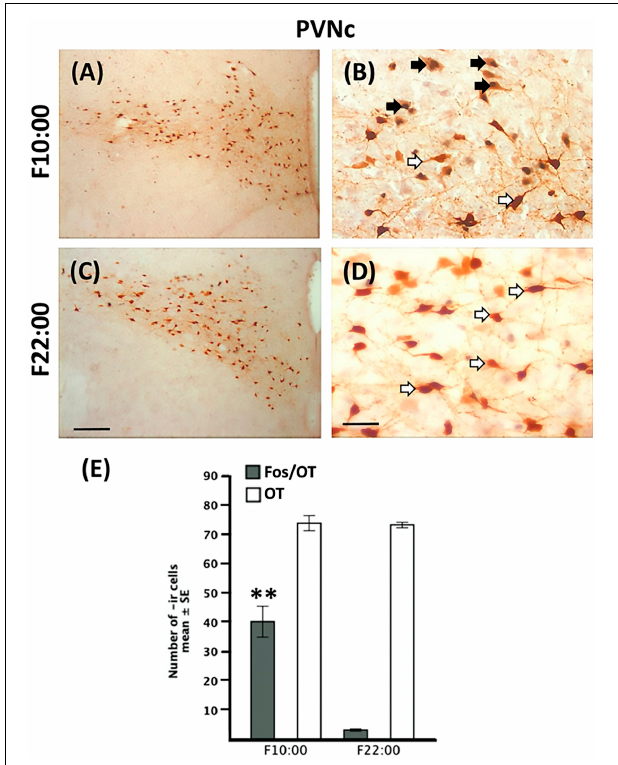
FIGURE 5 | Persistence of Fos-/OT-ir cells in the PVNc in fasted subjects. Photomicrographs of representative sections of the PVNc of fasted subjects at the time of previous scheduled time of nursing (A) and 12 h after (C) and magnifications of the respective time points (B,D) . Note the increase of Fos-/OT-ir cells at the time of previous scheduled nursing (A,B) in fasted subjects and a decrease 12 h later (C,D) . (E) Quantitative analysis of OT- and Fos-/OT-ir cells in fasted subjects at the time of previous scheduled time of nursing (F10:00) and 12 h (F22:00) later. White arrow, OT-ir; black arrow Fos-/OT-ir. ∗∗ P < 0.001, denotes significant difference between F10:00 and F22:00 Fos-/OT-ir cell groups. Scale bar (A,C) , 100 µ m; (B,D) , 50 µ